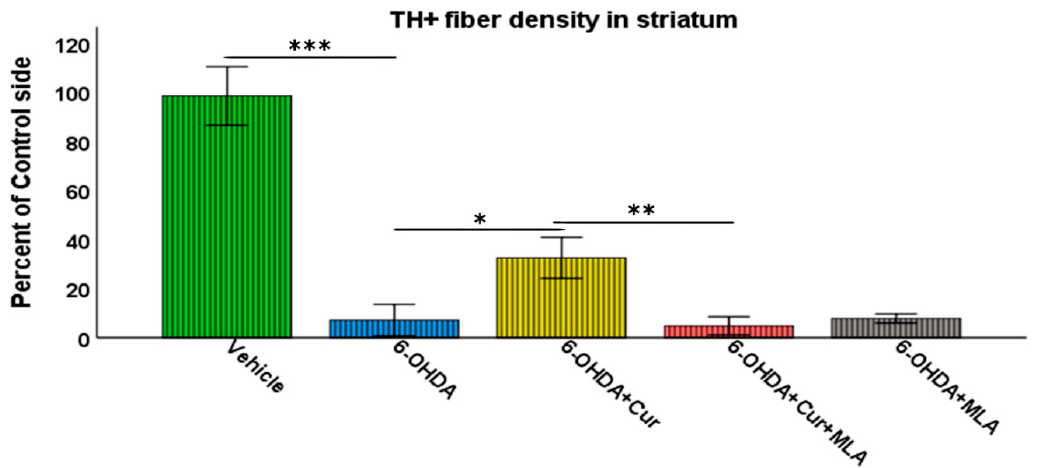
Figure 3. Striatal TH-immunoreactive fiber density expressed as a percentage of the fiber density on the lesioned side to the non-lesioned side. The density was measured at four rostro-caudal levels of the striatum: rostral ( + 1.56 mm), middle 1 ( + 0.72 mm), middle 2 ( + 0.12 mm), and caudal ( − 0.24 mm) relative to the bregma. The multiple intra-striatal 6-OHDA injections caused extensive damage to TH-positive fibers throughout the four levels of striatum compared with the vehicle-treated group (ANOVA, p < 0.000 ***). The neuroprotective e ff ect of curcumin, through an α 7-receptor-mediated mechanism, was marked in the curcumin-treated group at all rostro-caudal levels of striatum in comparison with the 6-OHDA-injected group (ANOVA, p < 0.011 *). MLA, an α 7-receptor blocker, reversed the protective effect of curcumin in the 6-OHDA+Cur+MLA group in comparison with the 6-OHDA+Cur-treated group (ANOVA, p ˂ 0.005 ** at all levels). The MLA antagonist had no effect